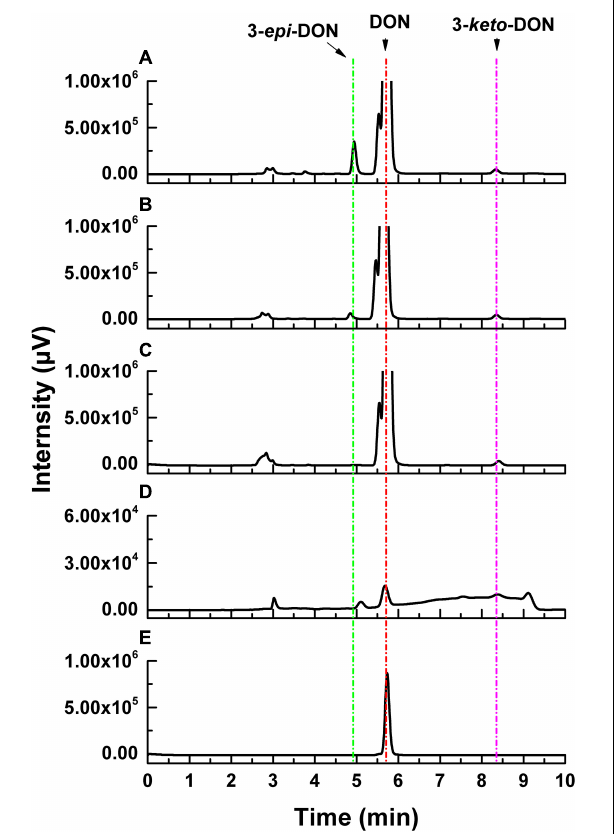
FIGURE 4 | High-performance liquid chromatography analysis of DON degradation by Nocardioides sp. ZHH-013 after (A) 8 h, (B) 4 h, (C) 0.5 h, and of (D) 3- keto -DON produced by DepA. (E) The 3.37 mM DON